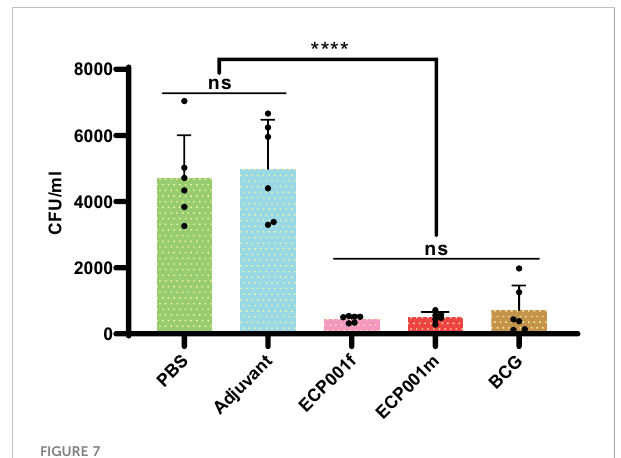
FIGURE 7 Results of the ECP001f and ECP001m groups compared with the PBS, adjuvant and BCG groups in terms of colony count. The PBS group is the negative control group; the adjuvant group is the blank control group, and the BCG group is the positive control group. Signi fi cant differences between the groups are indicated by an asterisk above the line. (ns **** P